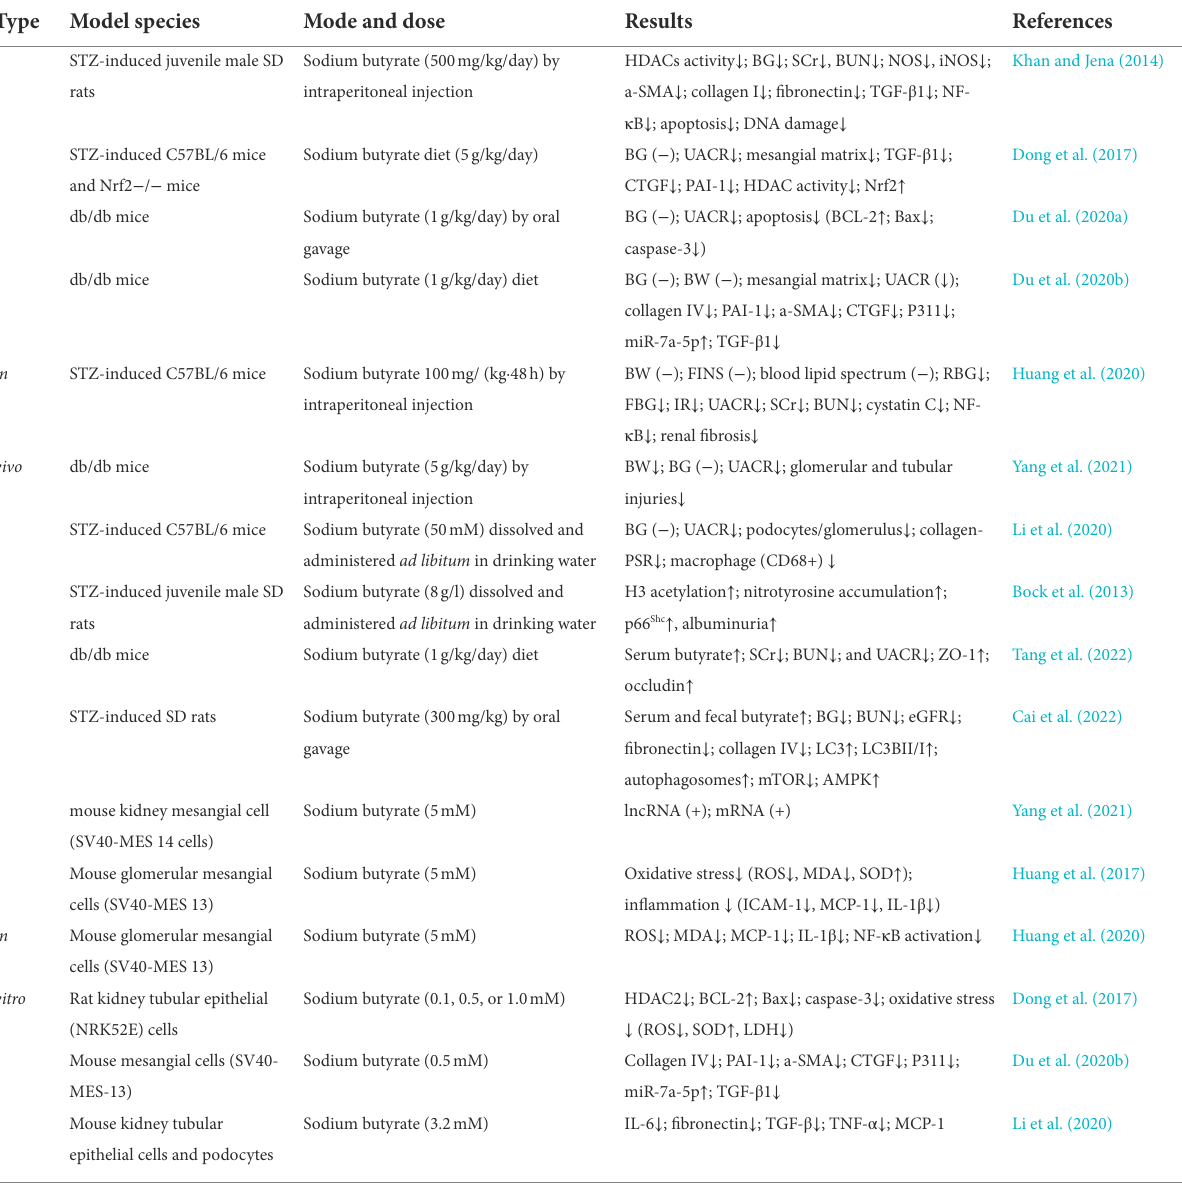
TABLE 1 Application of butyrate in vivo and in vitro model of